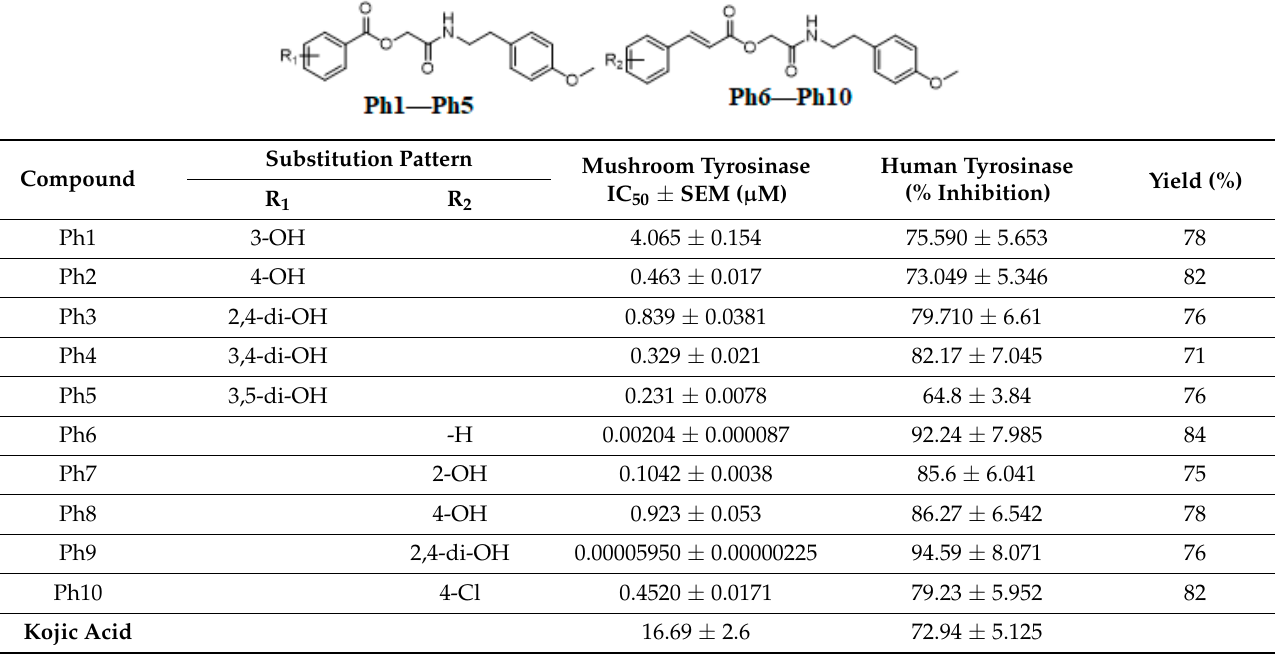
Table 1. The substitution pattern and inhibitory effects of Ph derivatives (Ph1 – Ph10) on mushroom tyrosinase and human tyrosinase (From melanoma cells).